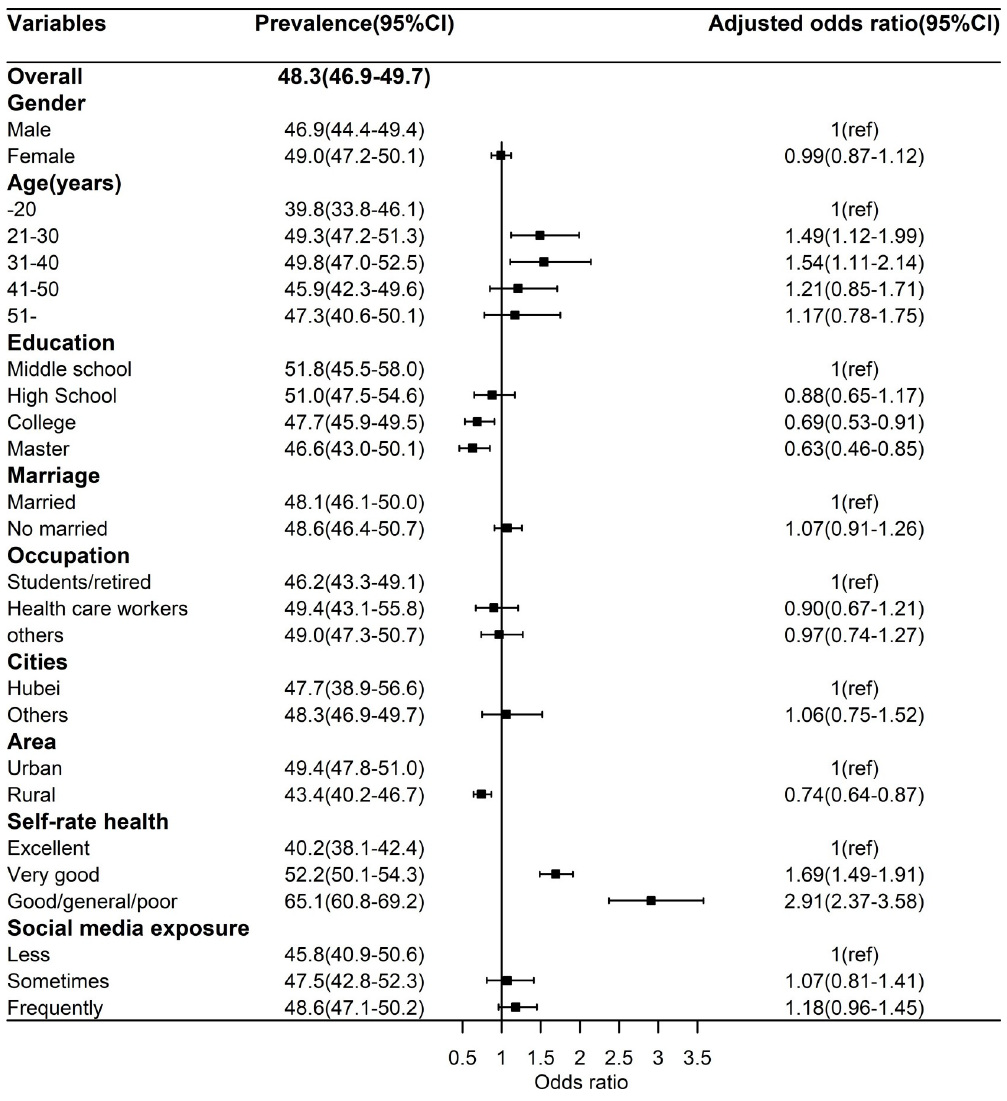
Fig 1. Prevalence of depression and relevant